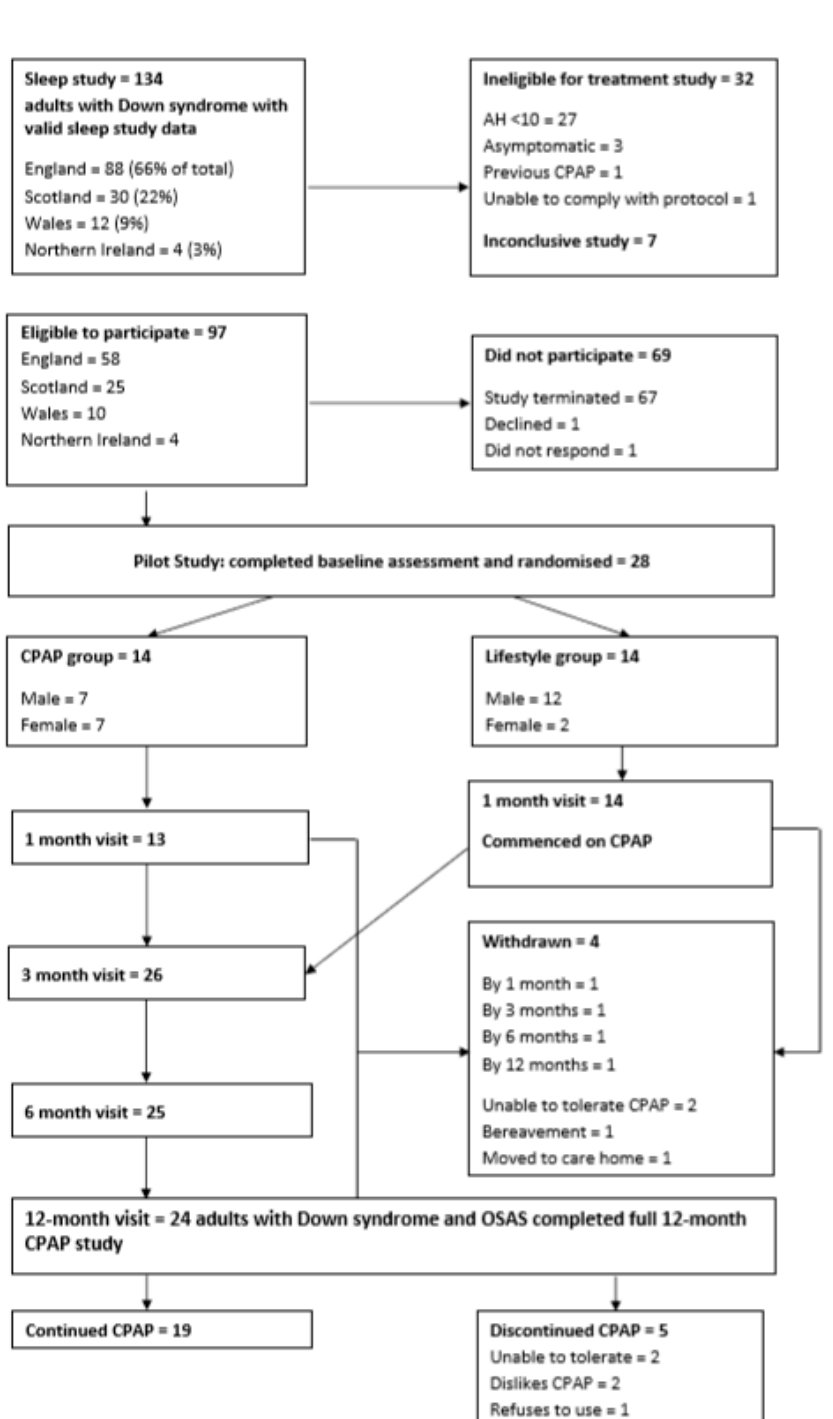
Figure 2. CONSORT diagram summarising enrolment in and completion of the treatment phase of the study.